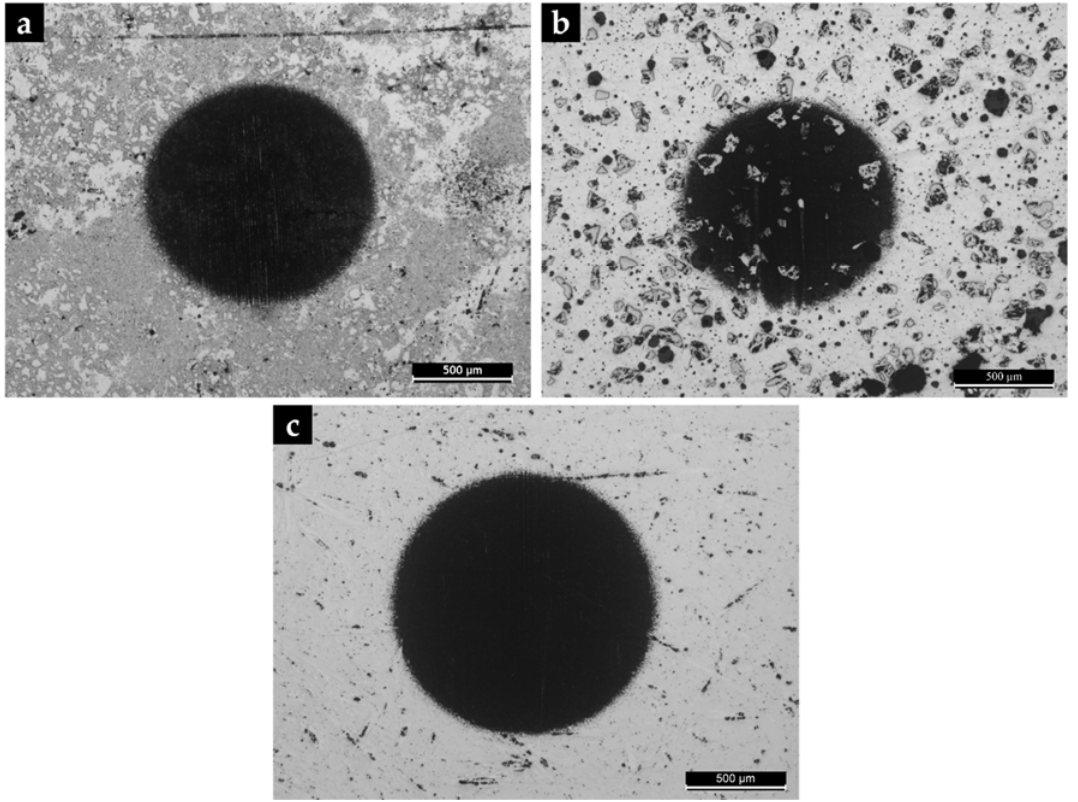
Figure 9. OM images of the worn craters corresponding to a sliding distance of 31.4 m. ( a ) TiC-WCI reinforcement, ( b ) WC-WCI reinforcement, and ( c ) base metal.